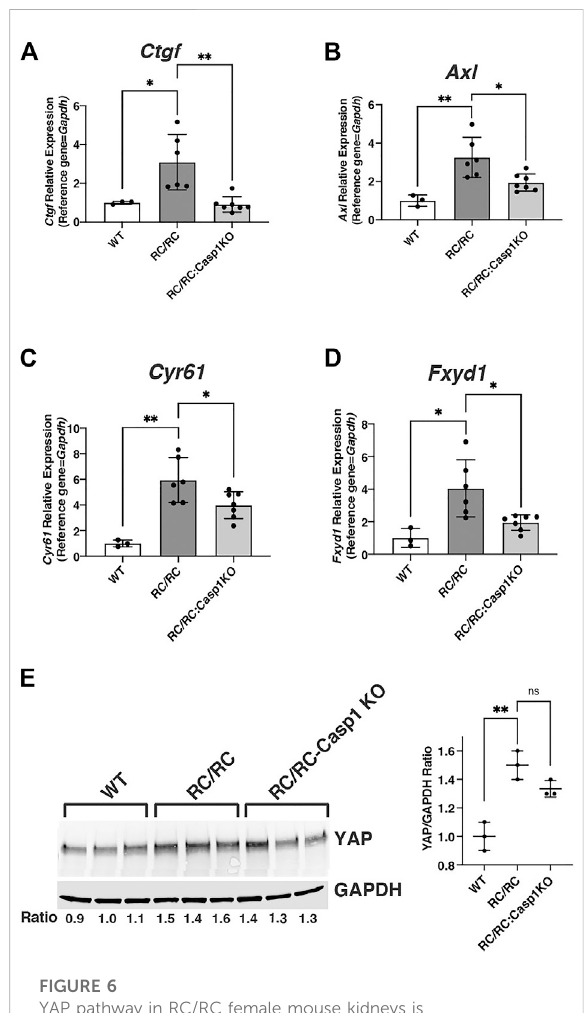
YAP pathway in RC/RC female mouse kidneys is downregulated by Casp-1 KO. (A – D) qRT-PCR of YAP transcript targets from WT, RC/RC and RC/RC: Casp-1 KO female mouse kidneys: (A) Ctgf ; (B) Axl ; (C) Cyr61 and (D) Fxyd1. (E) Western blots of YAP and GAPDH from protein samples of WT, RC/RC, and RC/RC: Casp1 KO female kidneys (3